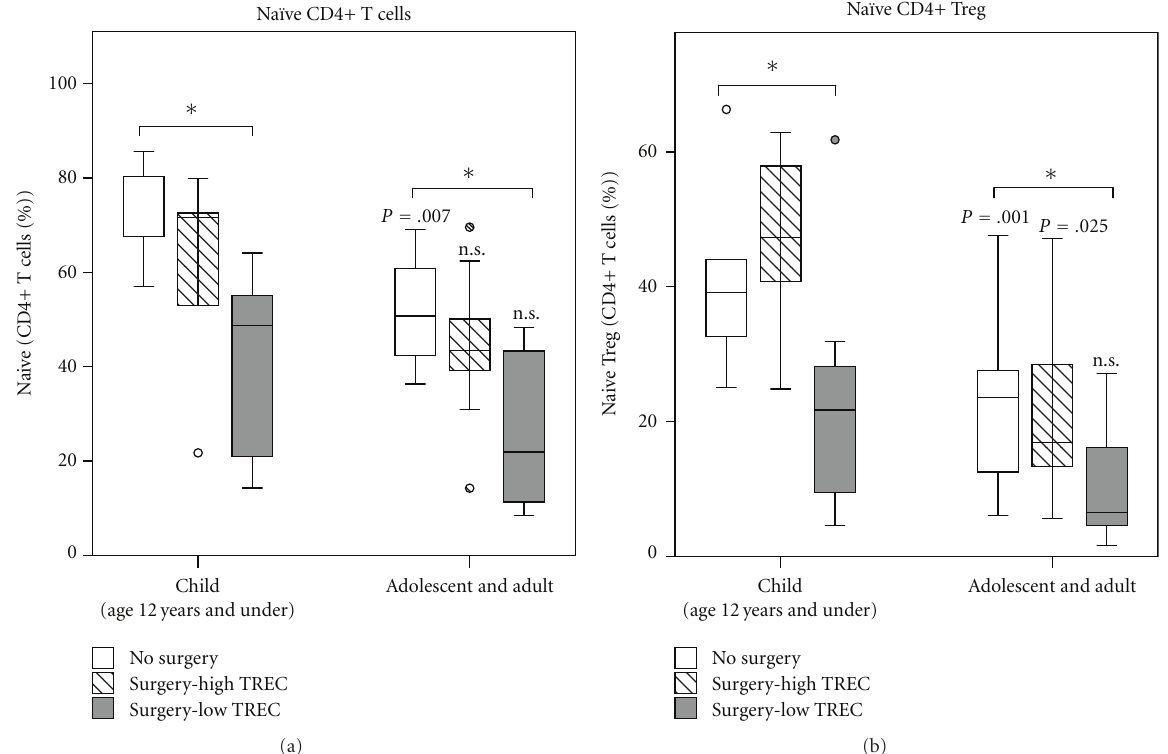
Figure 5: Proportion of na¨ıve CD4+ and Tregs. Proportion of CD4+ T cells and Tregs that are na¨ıve (CD27+CD45RA+ or CD45RA+ for Treg) were examined by age group. In subjects with no surgery, proportion of CD4+ T cells and CD4+ Tregs that are na¨ıve decrease between childhood and adulthood ( P = . 007, P = . 025; Mann-Whitney test). In subjects with low TREC median proportion of na¨ıve cells is reduced compared with no Surgery at each age ( ∗ P < . 03), but there is no di ff erence between children and adults ( P = n.s. for both; Mann-Whitney